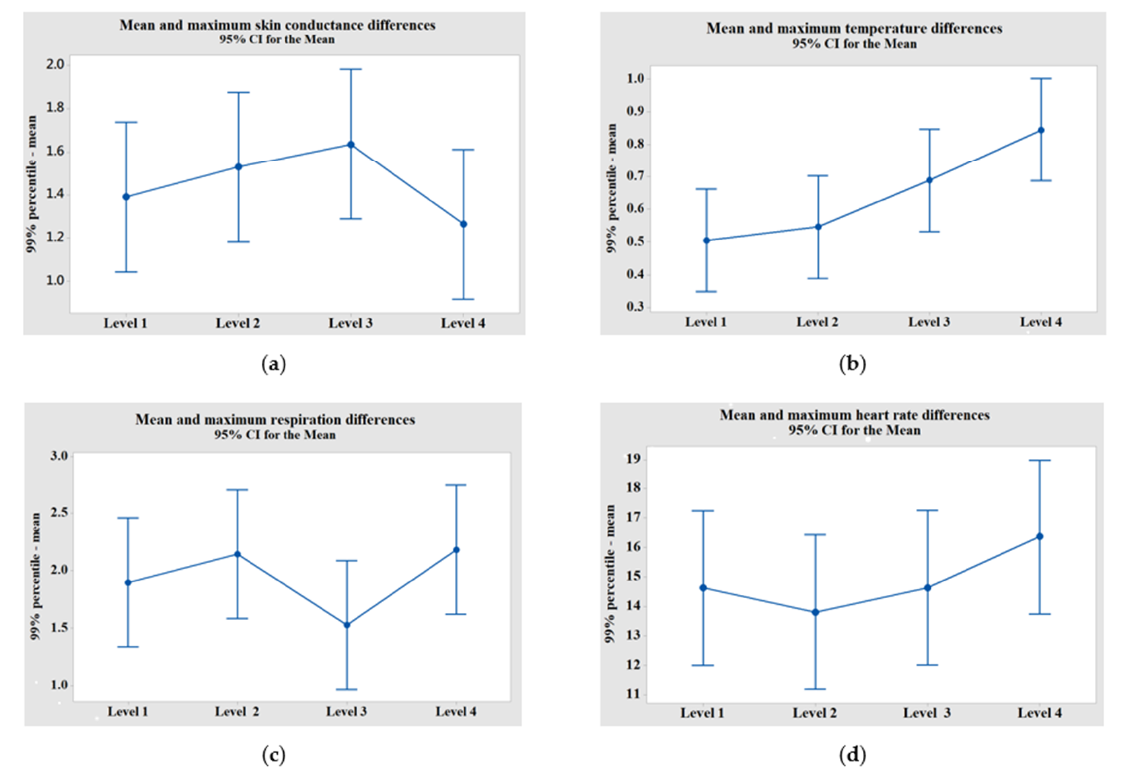
Figure 9. ( a ) Mean and maximum skin conductance differences; ( b ) mean and maximum body temperature differences; ( c ) mean and maximum respiration differences; and ( d ) mean and maximum heart rate